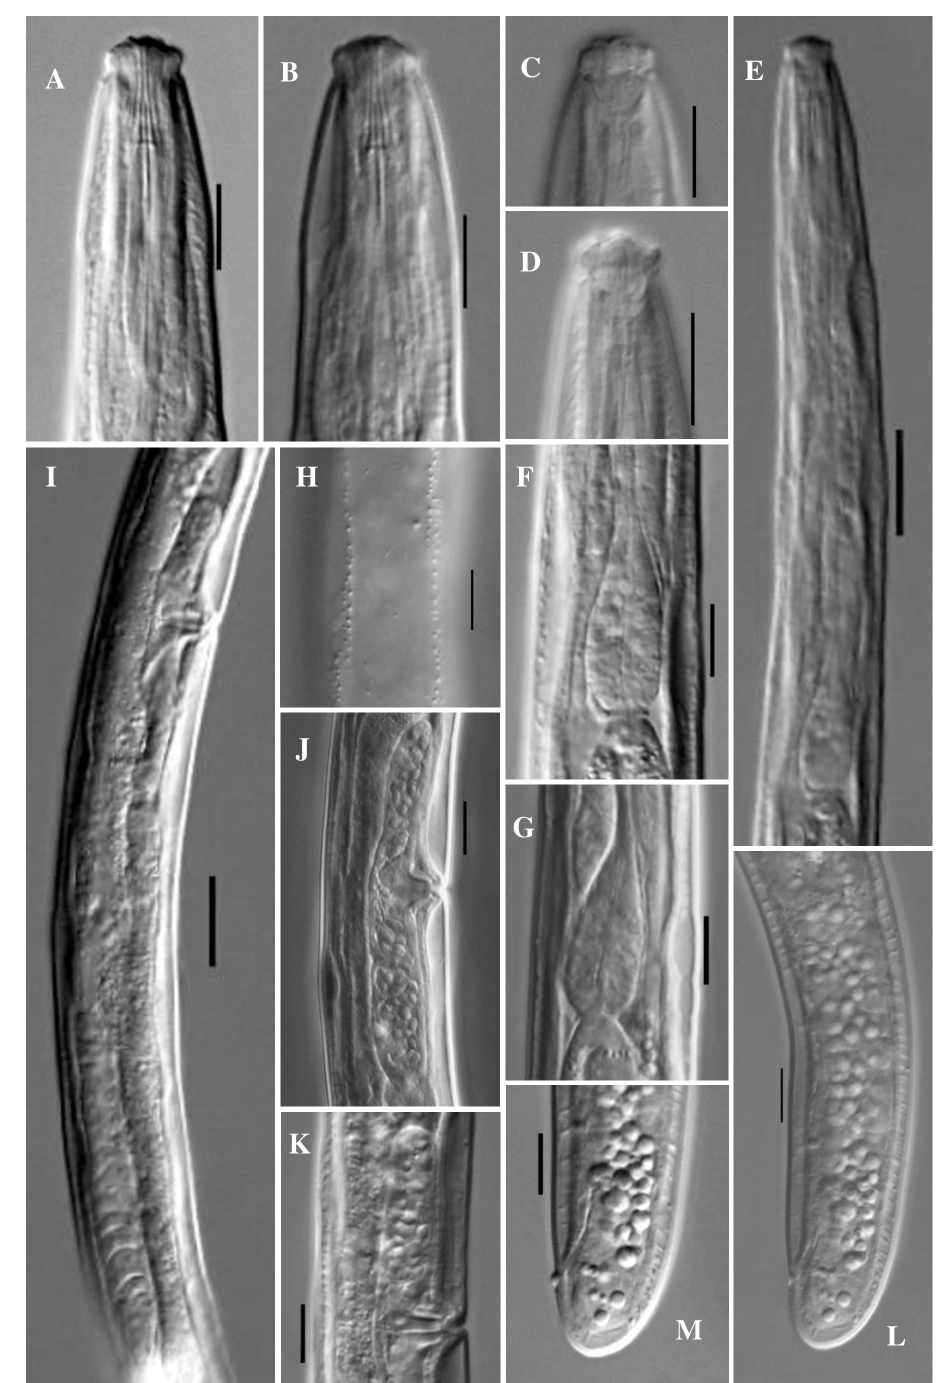
Fig. 13. Basirotyleptus goaensis sp. nov., ♀ (LM photographs). A–B, D–M . Paratypes (AMU/ZD/NC/ Basirotyleptus goaensis /2–6). A, D–F, H, K . Paratype 1. B, G, J . Paratype 2. C . Holotype (AMU/ ZD/NC/ Basirotyleptus goaensis /1). I . Paratype 4. L . Paratype 5. M . Paratype 3. A–B . Anterior region. C–D . Anterior region showing amphid. E . Pharyngeal region. F–G . Pharyngeal bulb. H . Cuticle showing punctations. I–K . Genital system. L . Posterior region. M . Posterior end. Scale bars: A – D, F – H, J–K, M = 10 µm; E, I = 20